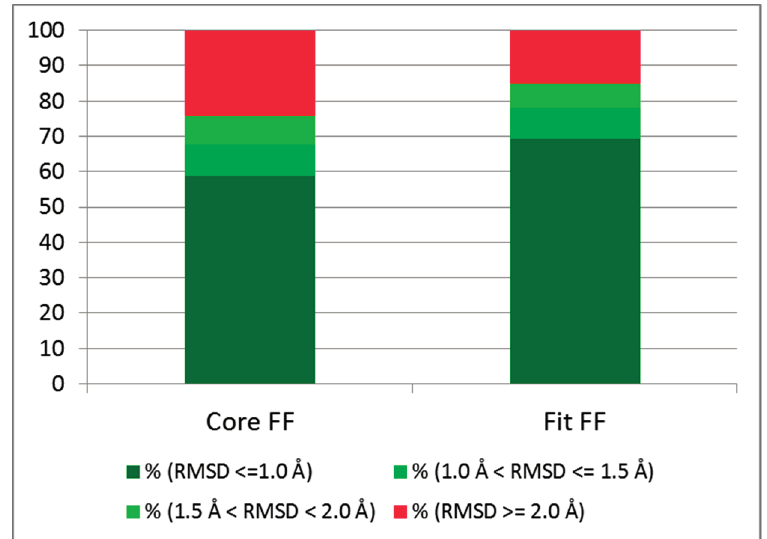
Figure 6. Docking performances on the Astex Diverse Set for both Core FF and Fit